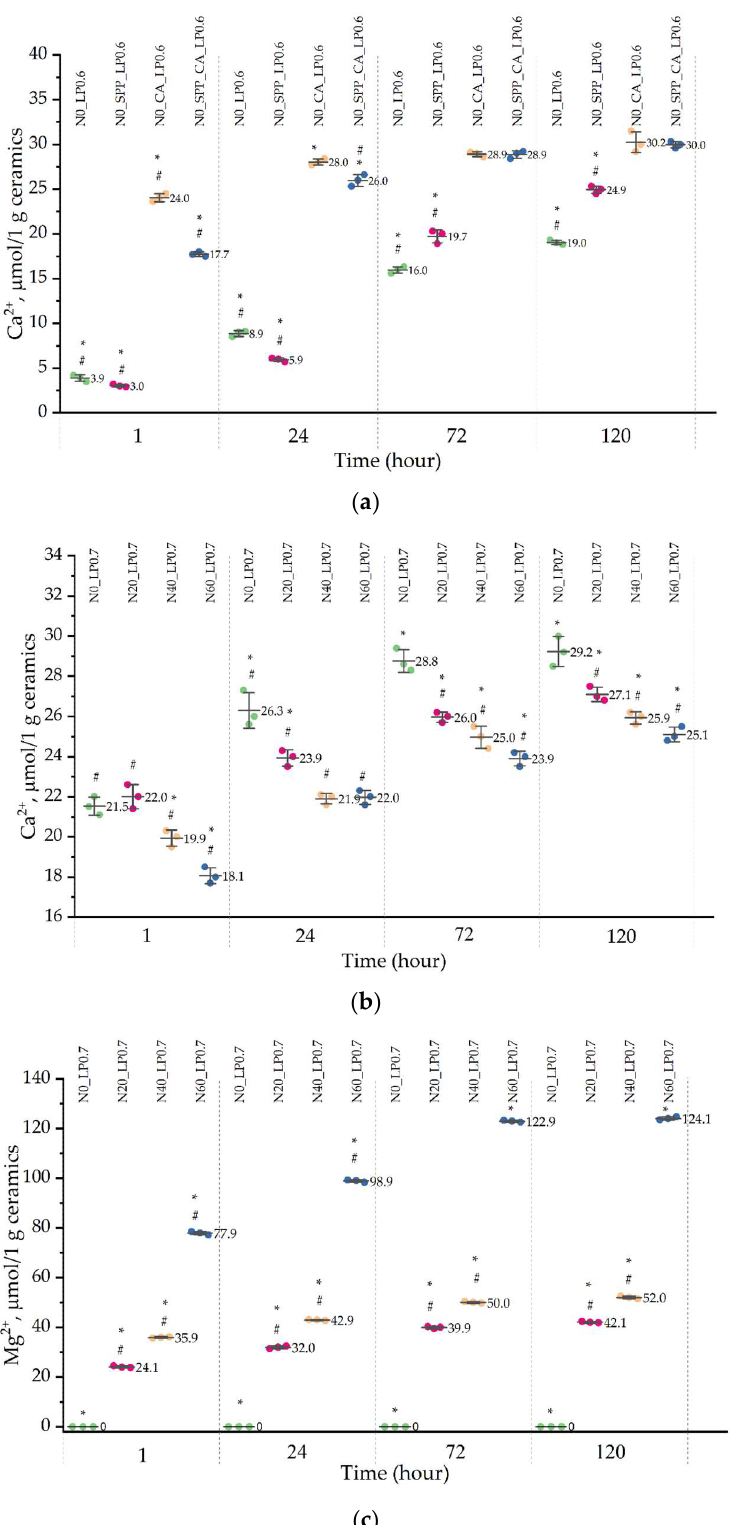
Figure 7. Behavior of samples of ceramics in saline solution during exposure: change in concentration of Ca 2+ ions when introducing retarders into the composition: N0 ( a ), Ca 2+ ions for N0, N20, N40, 60 ( b ) and Mg 2+ ions for N0, N20, N40, N60 ( b , c ). Significant differences ( p < 0.05) within one group of materials at consecutive time points are labeled #, and significant differences at a specific time point between different groups are labeled with *.